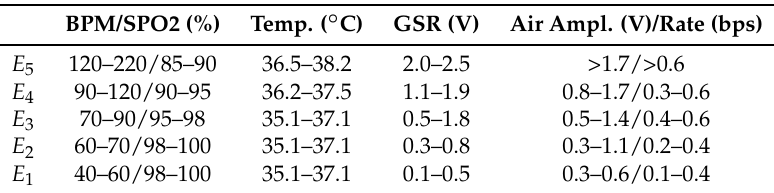
Table 1. Range of values for health-status classification in adult athletes (bps = breathes per second; Air ampl. is limited by the system to 2.5 V).